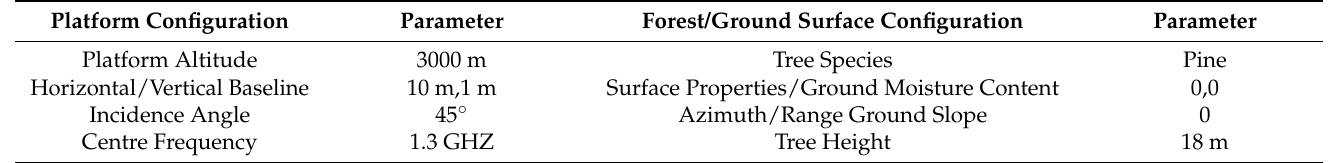
Table 1. ESA’s PolSARproSim module simulated nine groups of stand-specific parameters. Conif- erous forest densities ranged from 100 stems/ha to 900 stems/ha. The reference heights are all 18 m, the azimuth and range slope are all 0, and the ground roughness and soil wetness are 0. Terrain, shrub layer, and temporal decoherence do not influence the echo signal or inversion